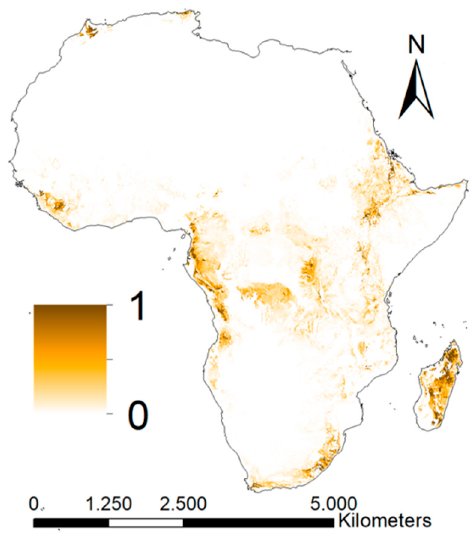
Figure 5. Geospatial variation of the process associated with sedimentation. The map resulted from the Universal Soil Loss Equation (USLE) equation (Equation 2), the watershed area and the flow velocity (Equation 6).